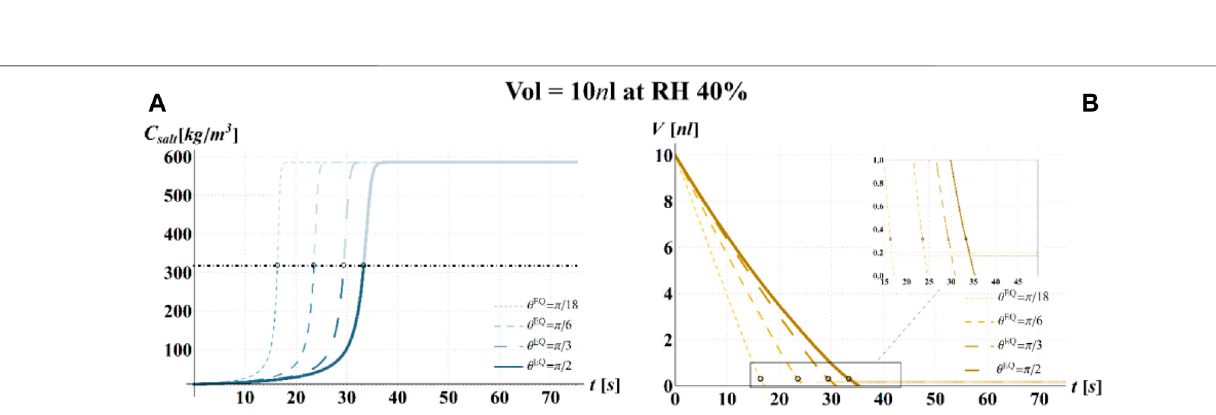
FIGURE5| Resultsofmodelsimulationsoftheevaporationprocessofasessiledropofaqueoussolutionwithastartingvolumeof10 nL,atanRH (cid:2) 80%,interms of time evolution of (A) the salt concentration, C salt , and (B) the volume, V, for fl at surfaces with different wettability, at T (cid:2) 25 ° C.